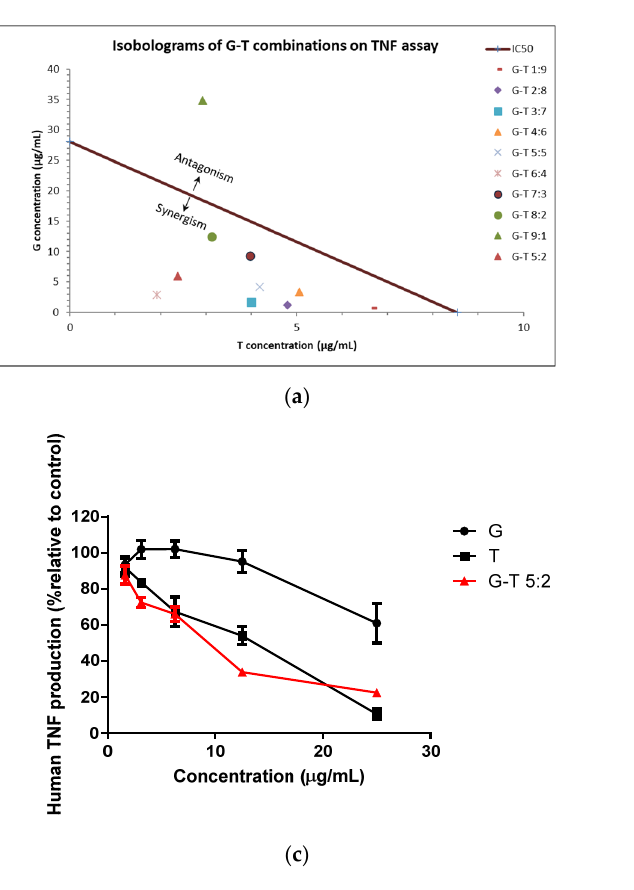
Figure 2. Synergistic interaction of G-T combination s (1:9, 2:8, 3:7, 4:6, 5:5, 6:4, 7:3, 8:2, 9:1, 5:2, w/w ) in in-hibiting LPS-induced TNF in THP-1 cells. Isobologram of G-T combinations in reducing TNF at IC50 ( a ), CI-Fa curve of G-T 5:2 ( b ), dose-response curves of G, T and G-T 5:2 on TNF assay ( c ) and cell